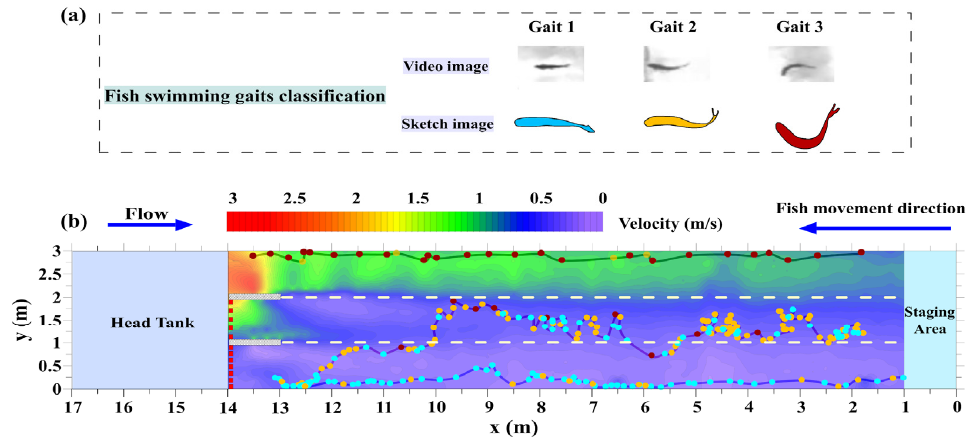
Figure 5. ( a ): Classification of fish swimming gaits and ( b ) the typical swimming routes with different gaits against the flow velocity (m/s). The different colored dots indicate the different gaits classified in ( a ).